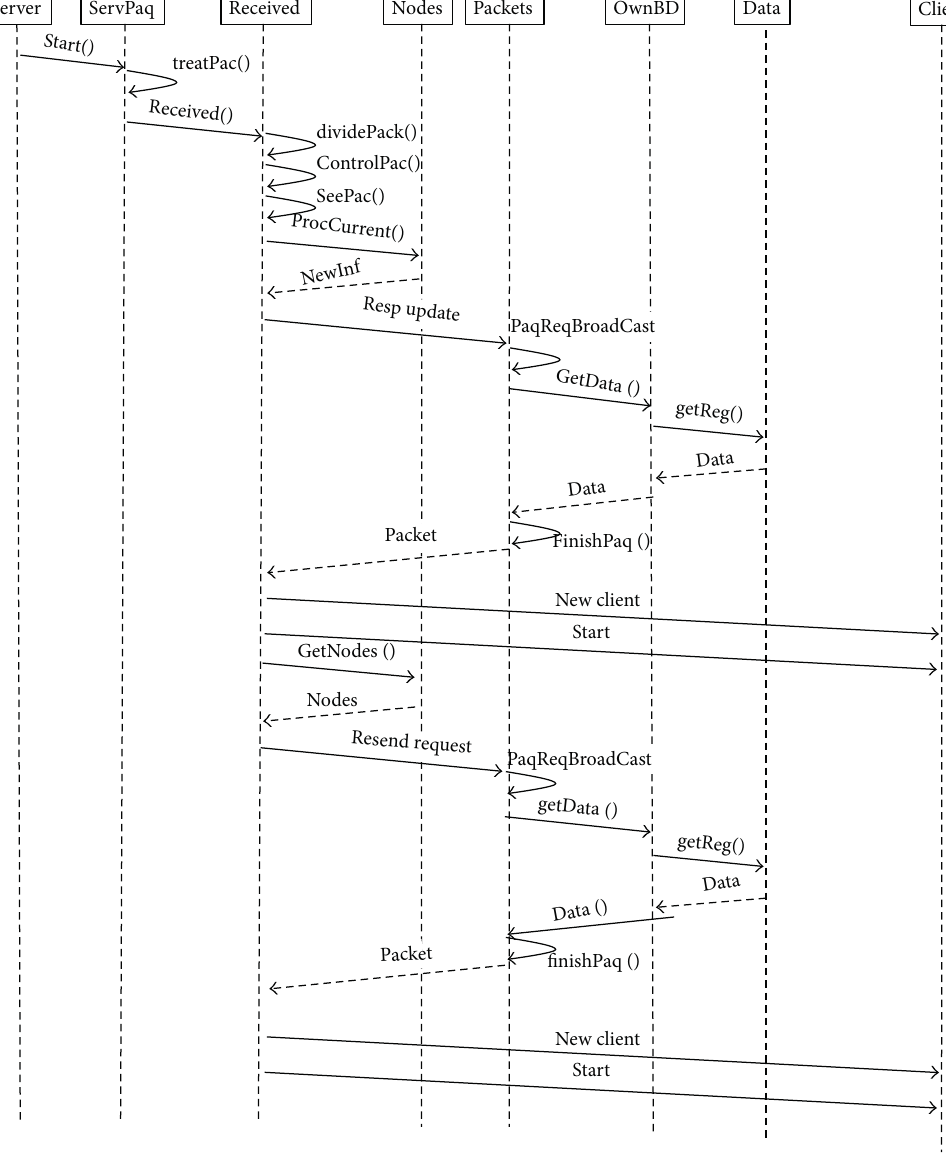
Figure 3: Procedure to process a